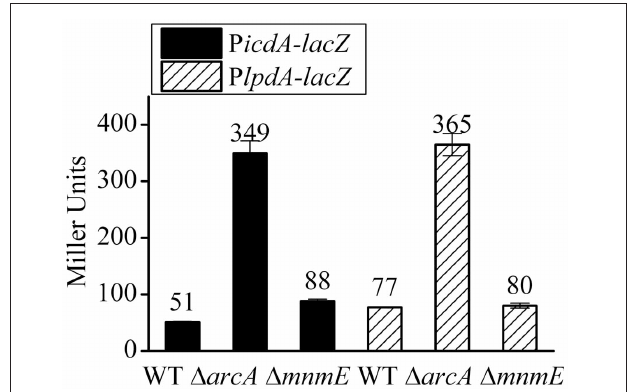
FIGURE 7 | MnmE has no effect on the transcription of P icdA-lacZ and P lpdA-lacZ , two ArcA dependent promoters. β -galactosidase activities of chromosomal P icdA - lacZ (black bars) and P lpdA-lacZ (stripe bars) fusions were measured from cells grown anaerobically to exponential phase (A 600 = 0 . 3) in minimal M9 glucose medium. Results are presented in Miller unit and error bars represent the standard errors of triplicate experiments ( n =